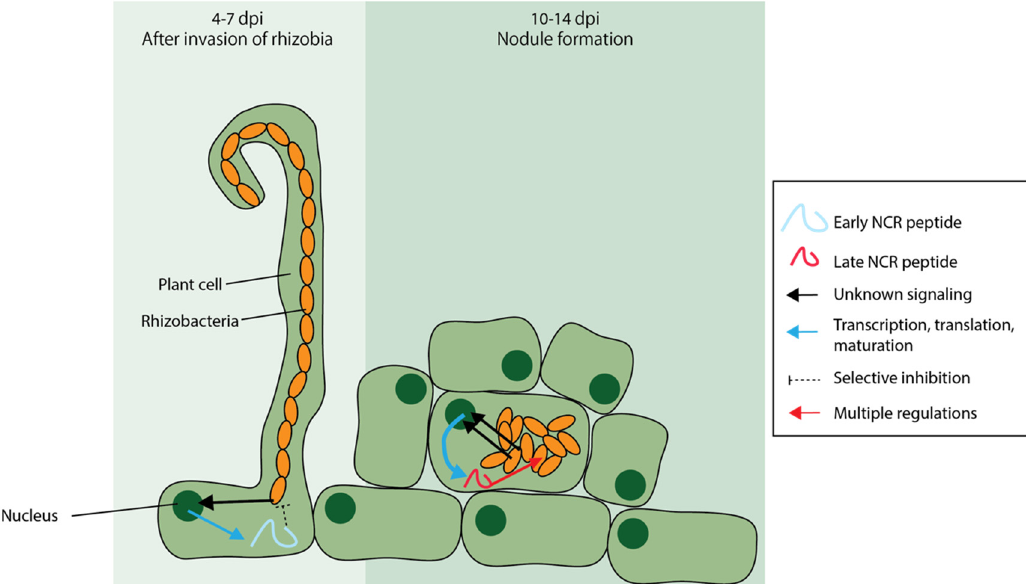
Figure 3. The secretion mechanism and modes of action of nodule-specific cysteine-rich (NCR) peptides. NCR peptides secreted at 4–7 days post inoculation (dpi) with rhizobia and at 10–14 dpi are classified as early and late NCR peptides, respectively [145]. The host root cells recognize unknown signals from the rhizobia and secrete NCR peptides, which may selectively inhibit incompatible